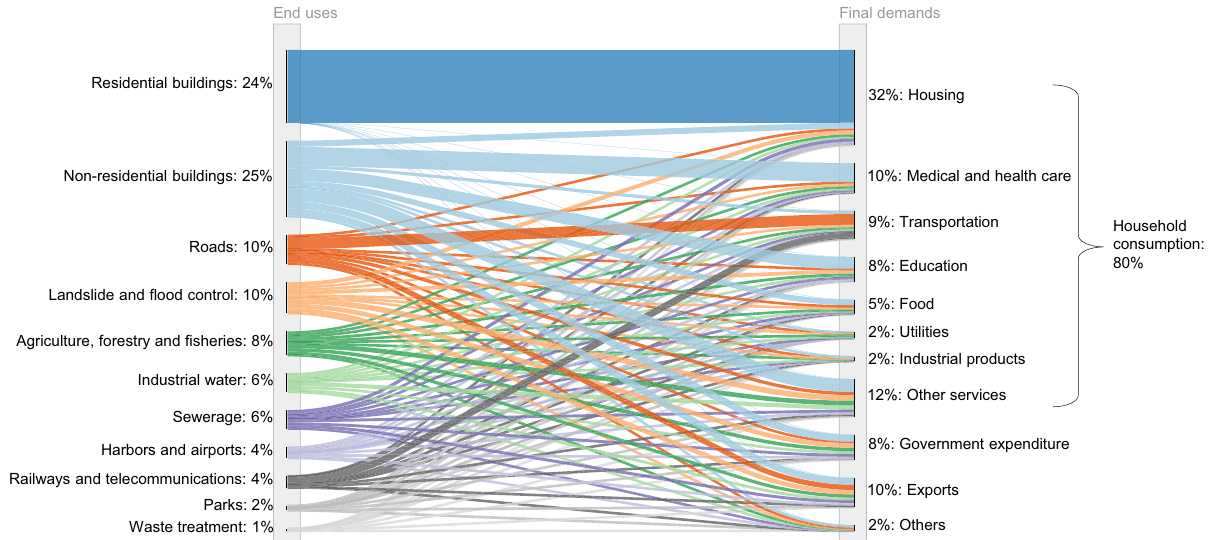
Fig. 2 Final demand drivers of cement fl ows in Japan in 2019. Due to data constraints, cement fl ow data as a proxy for concrete was connected to fi nal demand drivers using the latest Japanese input-output table 52 . Here, fi xed capital is endogenized by using an augmentation method 55 with the fi xed capital formation table in the supplementary material of the Japanese input-output